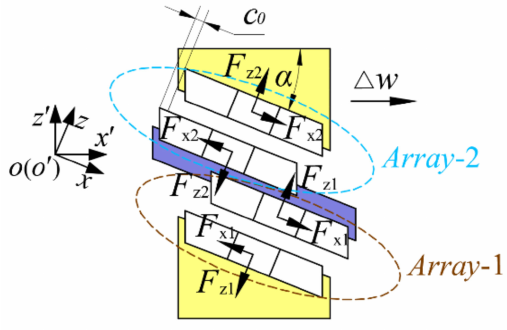
Figure 9. Two opposed Halbach arrays on same